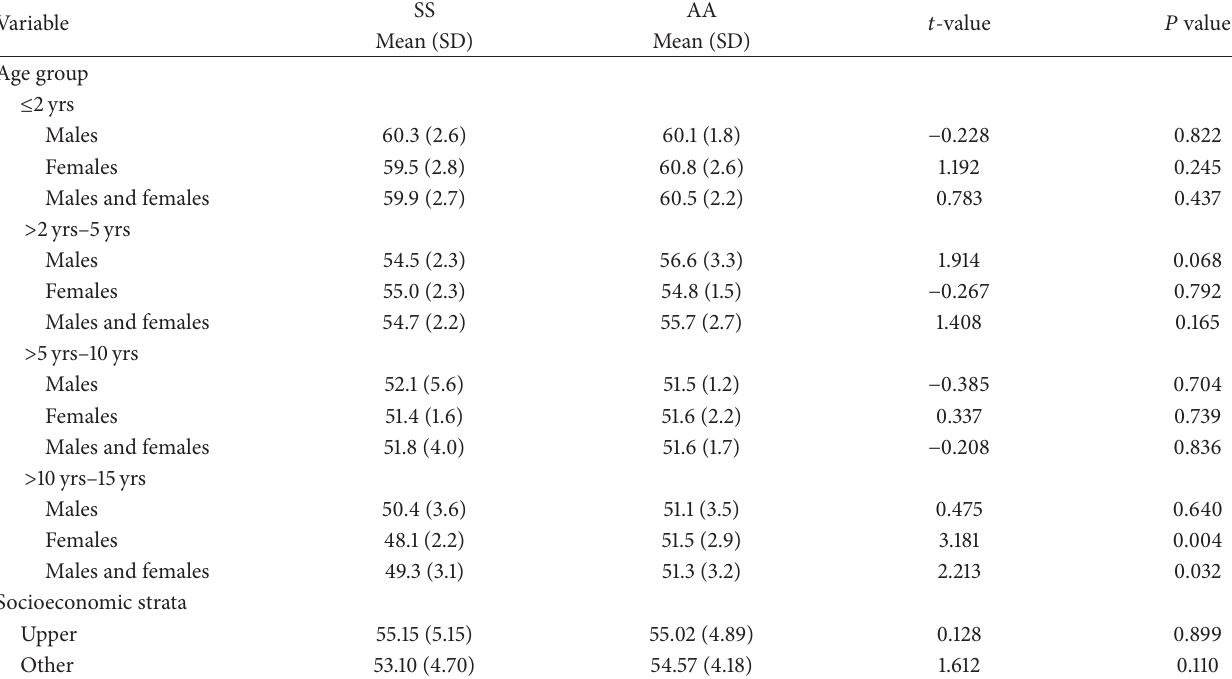
Table 1: Mean Cormic Index distribution of study subjects according to age and